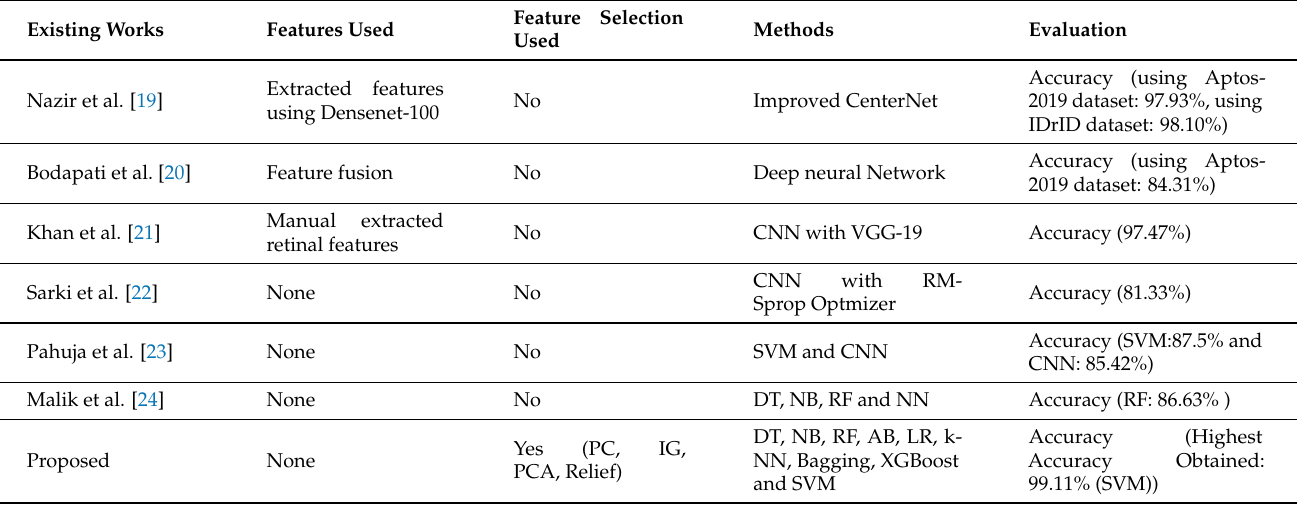
Table 10. Comparison with existing